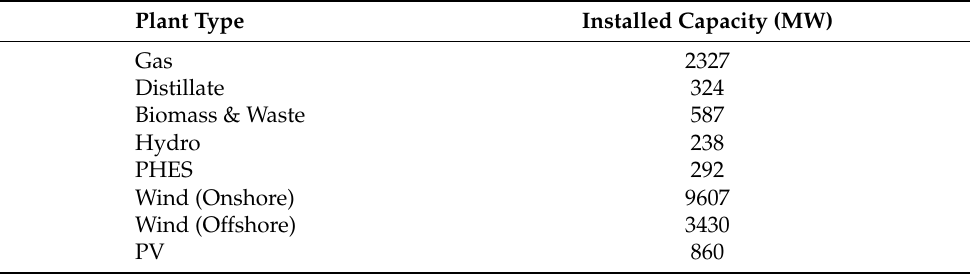
Table 1. Starting installed capacities in the base model.